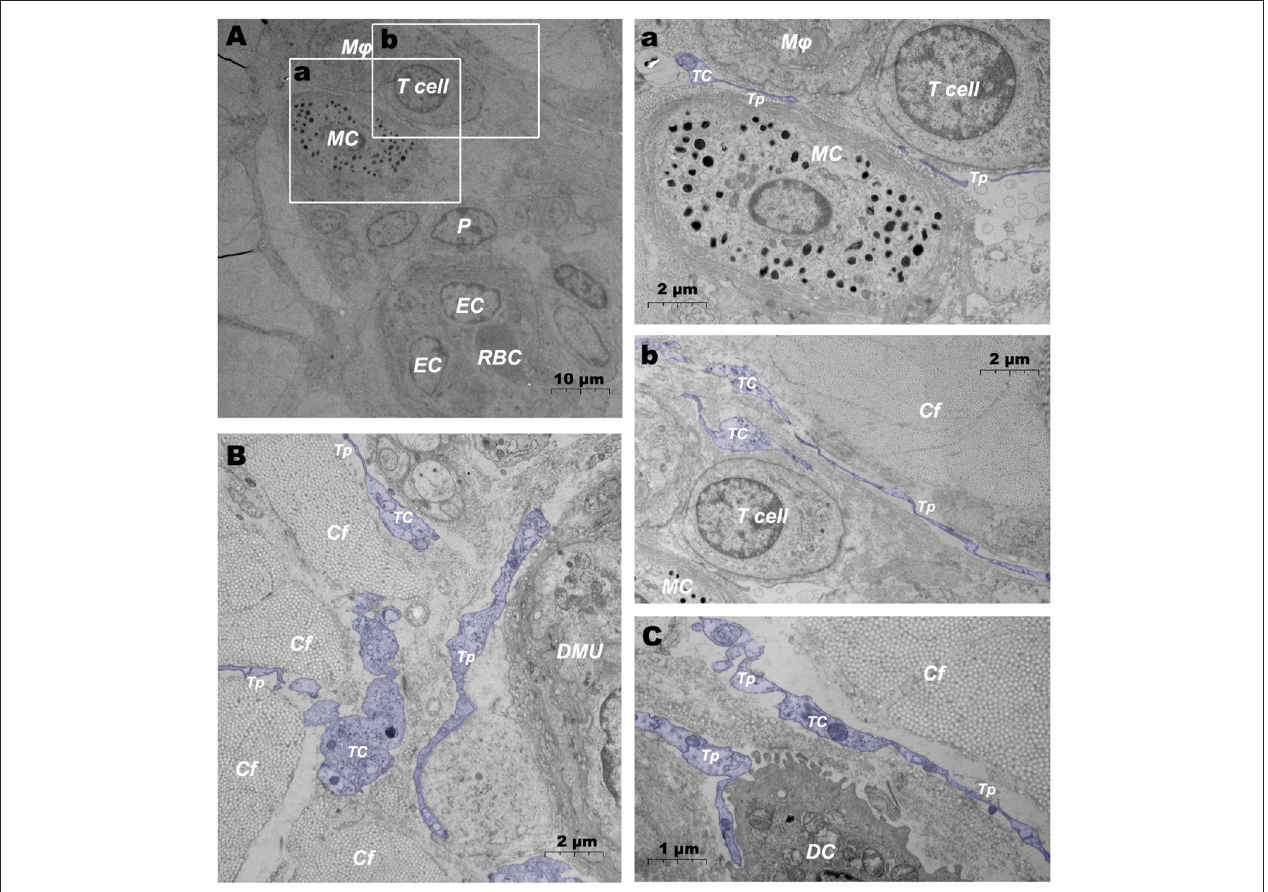
FIGURE 7 | Ultrastructural analysis of TCs in the steady state via TEM. (A) Location of TC in the DMUs in the steady state; (a) is the enlargement of the mast cell and surrounding TCs in (A) ; (b) is the enlargement of T cells and surrounding TCs in (A) ; (B) TCs surrounds the DMUs; (C) TC between collagen fibers and dendritic cells. RBC, red blood cell; EC, endothelial cell; P, Pericyte; MC, mast cell; M φ , macrophage; TC, telocyte; Tp, telopode; Cf, collagen fiber; DMU, dermal microvascular unit; DC, dendritic cell; Blue mark, telocytes. The scale bar (A) = 10 µ m; (B) (a,b) = 2 µ m; (C) = 1 µ